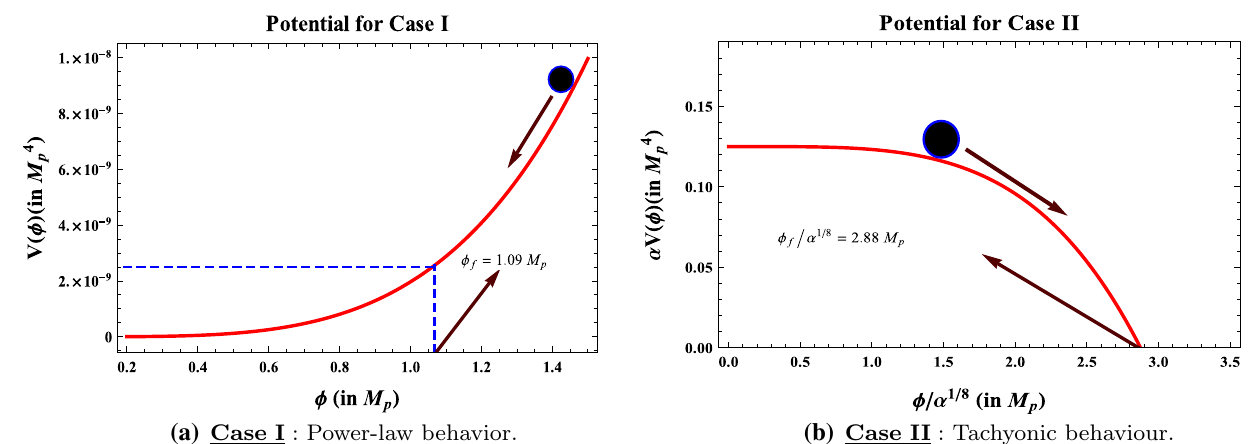
and the inflation ends at the field value φ f = 2 . 88 α 1 / 8 M p , where the lower bound on the parameter α is α ≥ 2 . 51 × 10 7 , which is consistent with Planck 2015 data